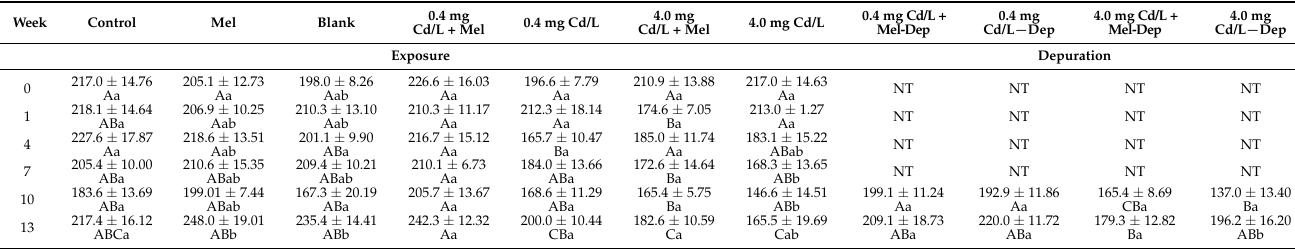
Table 2. Body weight (g) of female Prussian carp during 13 weeks of fish exposure to different doses of cadmium and 6 weeks